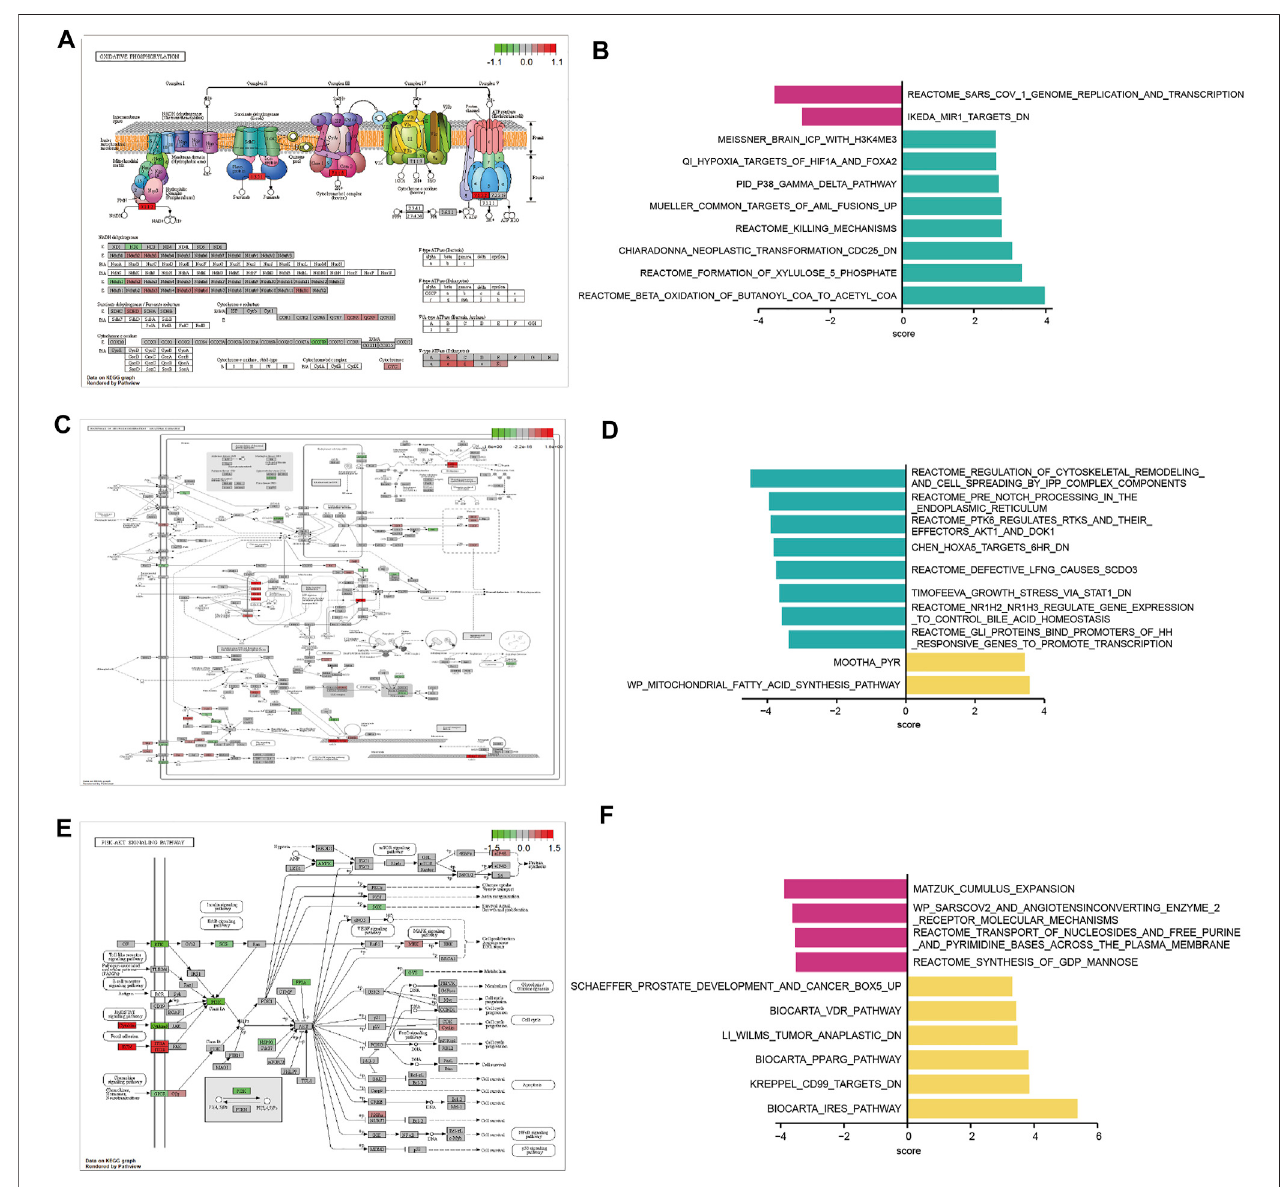
FIGURE 6 | Three m6A modi fi cation patterns differ in their underlying biological function characteristics. (A,C,E) Integrated KEGG pathway analysis and visualization of both gene expression and metabolomics data. Gene expression levels are indicated as signi fi cantly higher (red), unchanged (gray), or lower (green). The differences of hsa00190 Oxidative phosphorylation pathway between m6A modi fi cation pattern 1 and pattern 2 (A) . The differences of hsa05022: Pathways of neurodegeneration - multiple diseases between m6A modi fi cation pattern 1 and pattern 3 (C) . The differences of hsa04151: PI3K-Akt signaling pathway between m6A modi fi cation pattern2 and pattern 3 (E) . (B,D,F) Gene set variation analysis (GSVA) for signi fi cantly enriched pathways between subcluster 1 and subcluster 2 (B) , subcluster 1 and subcluster 3 (D) , subcluster 2 and subcluster 3 (F)